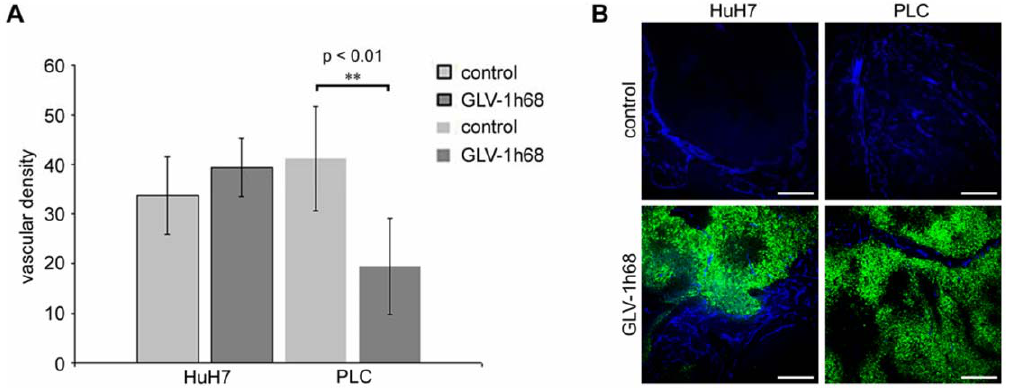
Figure 5. Analysis of GLV-1h68 virus-induced changes in HuH7- or PLC-tumor vascularization by confocal laser microscopy. Determination of vascular density using CD31 immunohistochemistry in virus- treated and non-treated HuH7 or PLC, tumors (A). The vascular density was measured in CD31-labeled tumor cross-sections (n=6 per group) and presented as mean values + / 2 standard deviations. The asterisks (**) indicate a significant difference between experimental groups (** P , 0.01; Student’s t -test). Confocal images of virus-treated and non-treated HuH7- or PLC-tumors (B). Tumor vasculature was labeled with anti-CD31 antibody (blue) and viral infection was indicated by GFP fluorescence (green). Scale bars represent 300 m m.